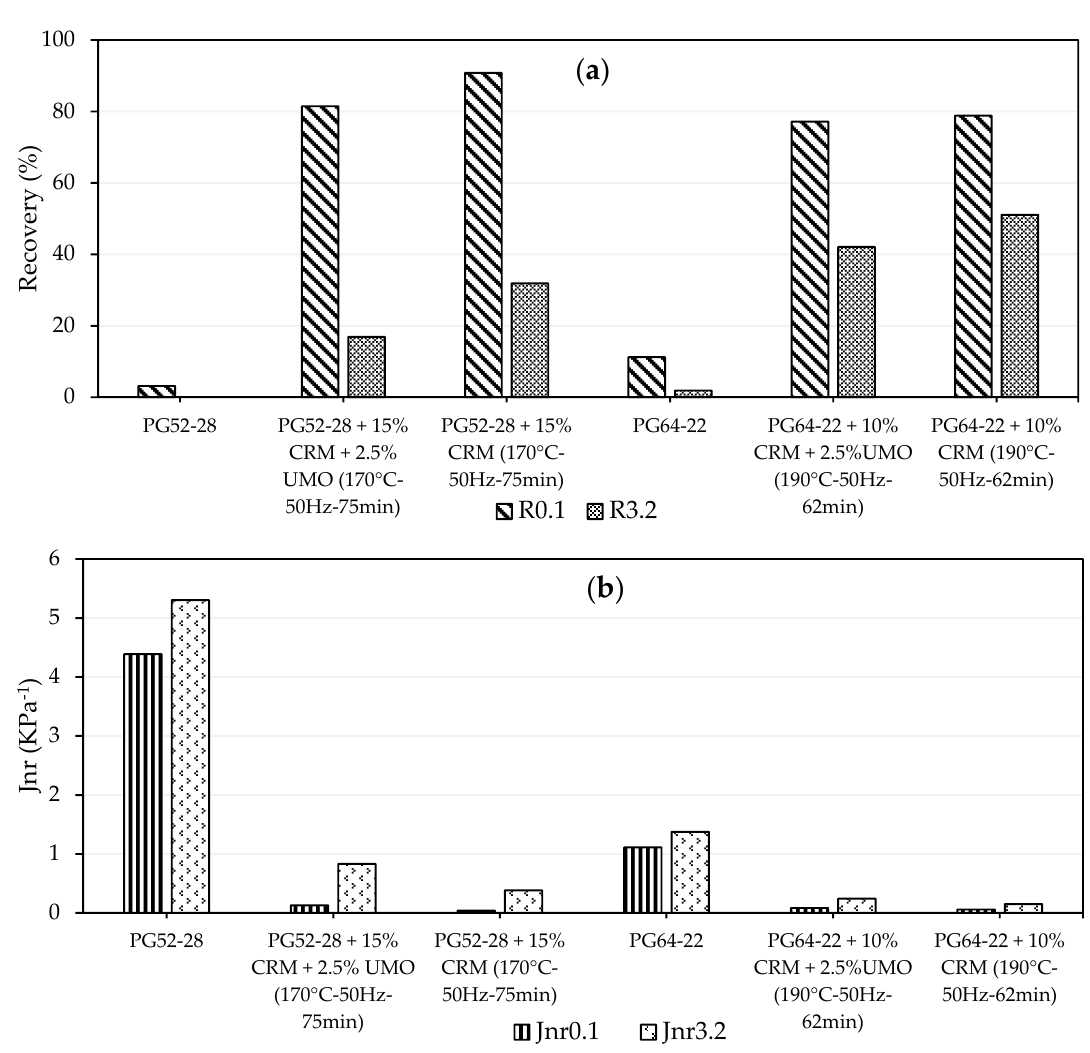
Figure 15. Effect of using CRM and UMO on: ( a ) elastic recovery ( b ) non-recoverable creep compliance for PG 52-28 and PG 64-22 neat and modified asphalt binders.